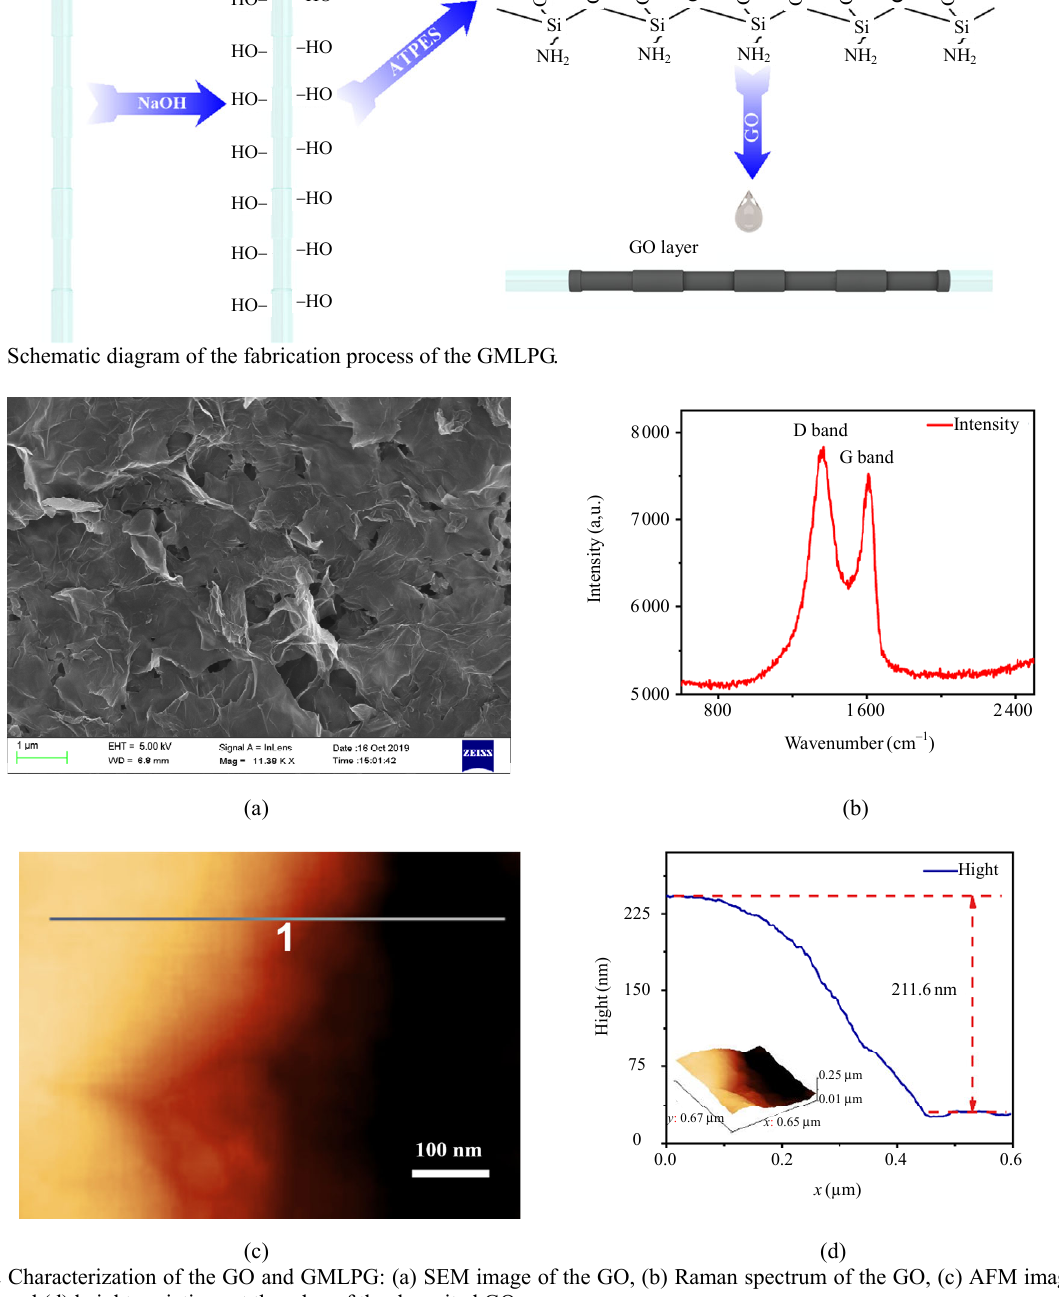
Fig. 2 Characterization of the GO and GMLPG: (a) SEM image of the GO, (b) Raman spectrum of the GO, (c) AFM image of the GMLPG, and (d) height variations at the edge of the deposited